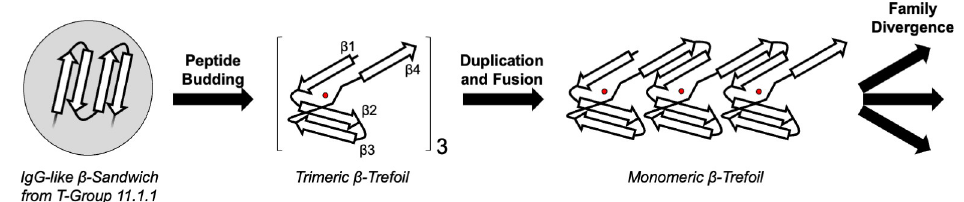
Fig 4. Emergence and evolution of the β -trefoil architecture. The peptide budding model hypothesizes that the first β -trefoil emerged when an excised segment from an IgG-like β -sandwich (grey shaded circle) trimerized to form a β - trefoil. This model of emergence is suggested by a preponderance of bridging themes between IgG-like β -sandwiches and β -trefoils ( Fig 1 ), their wide phylogenetic distribution among β -trefoils but narrow distribution among IgG-like β - sandwiches ( Fig 2A ), and the observation of a β TL motifs in a modern IgG-like β -sandwich protein ( Fig 3 ). The homo-trimeric β -trefoil was then duplicated and fused into a single domain, events predicted by Ponting and Russell [12] and demonstrated experimentally by Lee and Blaber [14]. The founding monomeric β -trefoil then gave rise to multiple β -trefoil families by both whole domain duplication and via a budding-like process of β -trefoil motifs, as described by Broom and coworkers [35]. As drawn, the embedded fragment in the IgG-like β -sandwich does not adopt a β -trefoil motif-like structure and is comprised of four β -strands. However, we do not exclude the possibility that the embedded peptide adopted a β -trefoil-like motif or that it was shorter than a canonical β -trefoil motif and underwent a duplication concurrent with the budding event.